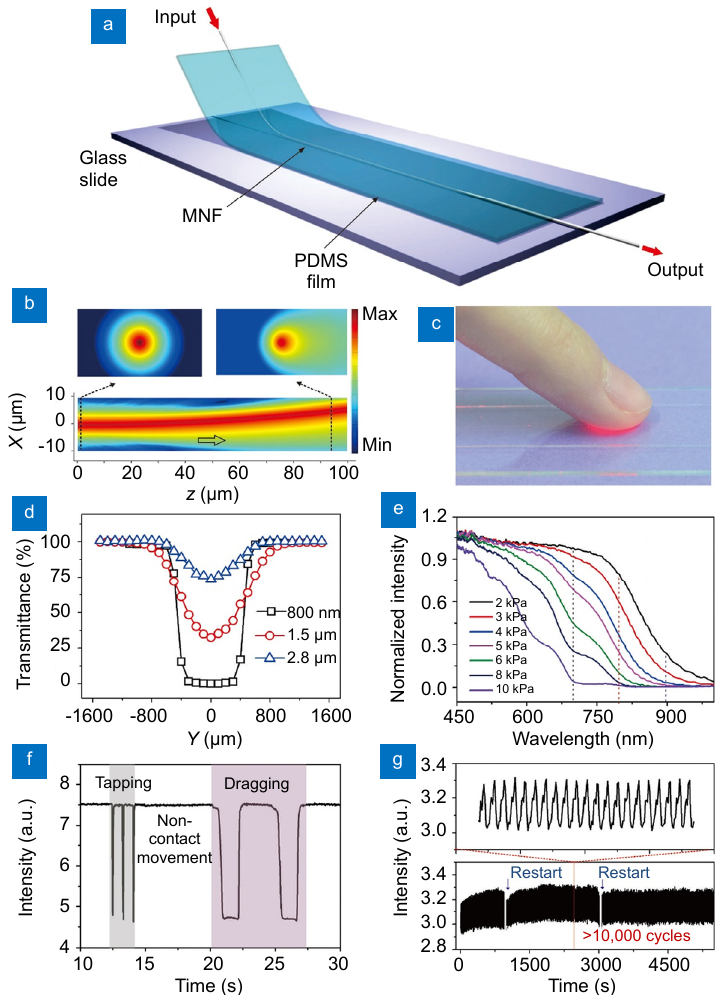
Fig. 2 | Characterization of substrate supported SLWOSs. ( a ) Schematic of testing a SLWOS on a glass slide. ( b ) Optical field intensity distri- butions of 900-nm-wavelength light guiding along a 1-µm-diameter glass MNF embedded in a 5°-bent SLWOS. ( c ) Photograph of light leaking ou t of a SLWOS upon a finger touch. ( d ) Lateral pressure response of a SLWOS with MNF diameters of 0.8, 1.5 and 2.8 µm, respectively. ( e ) Pres- sure response of a SLWOS with a wide spectral range. ( f ) Typical response of a SLWOS to finger movements of tapping, non-contact movement and dragging successively. ( g ) Long-term operational characteristics of a SLWOS measured by alternately applying/removing a 2-kPa pressure for more than 10,000